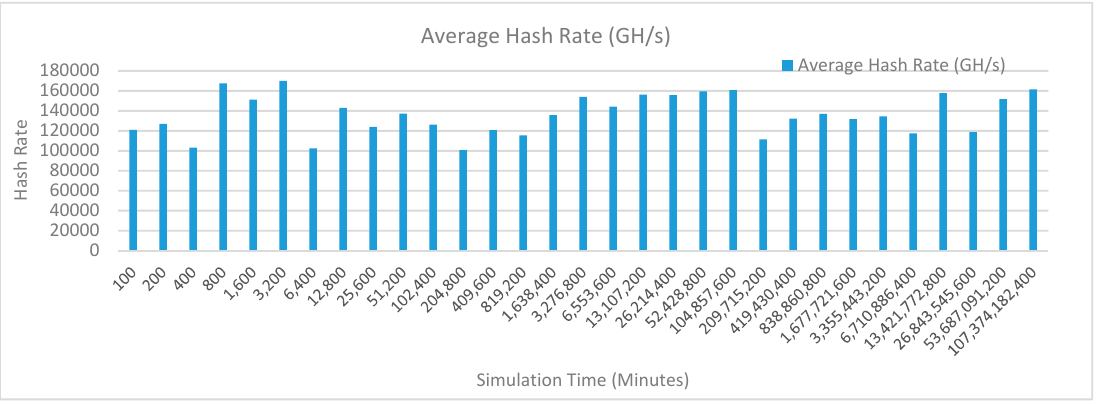
Figure 18. Average hash rate analysis (with IoT and edge).